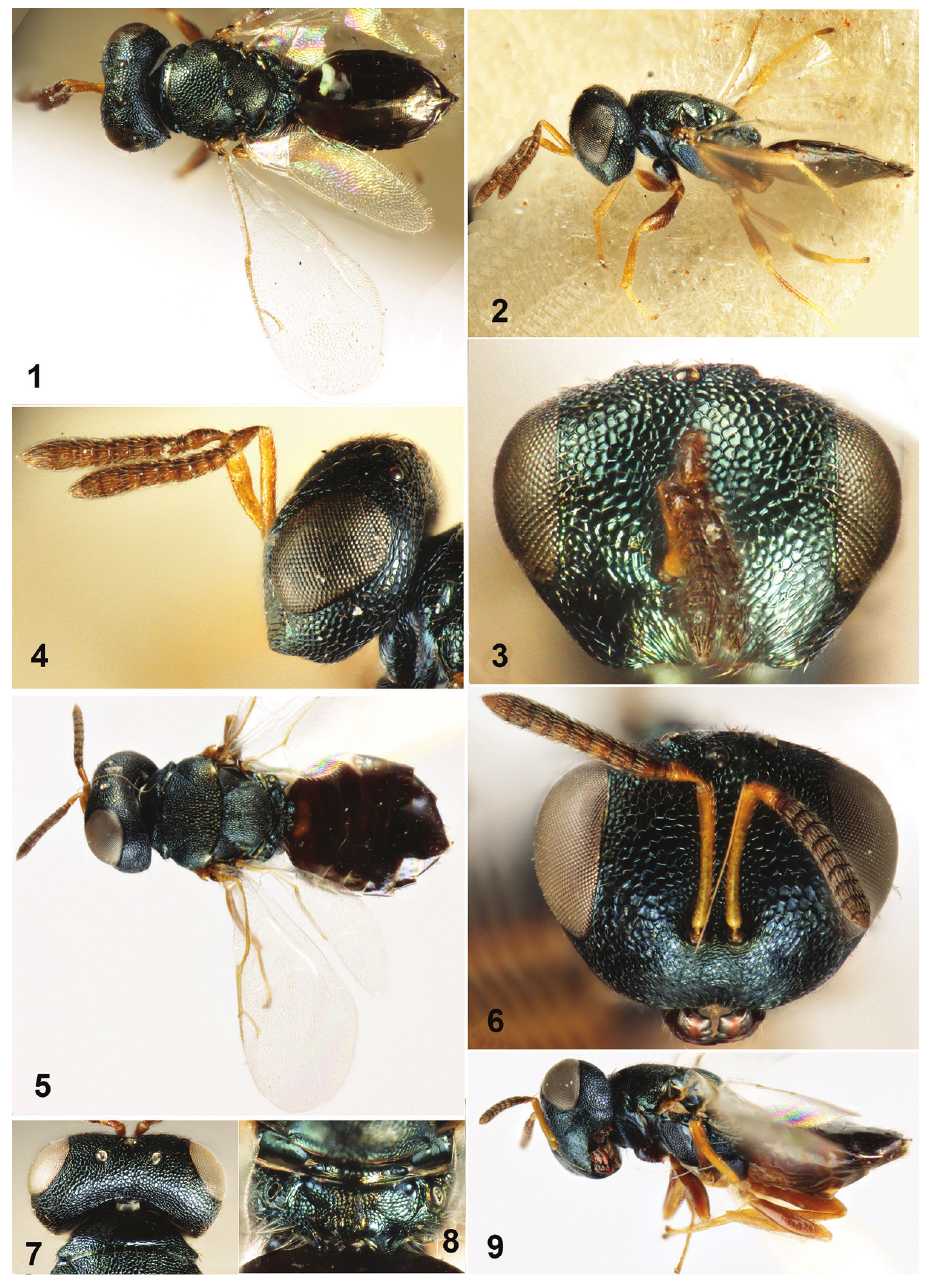
Figures 1–9. 1–4 Dibrachys hians Bouček, 1965. 1 Body in dorsal view 2 Body in lateral view 3 Head in frontal view 4 Head in lateral view 5–9 Dibrachys kojimae (Ishii, 1916) 5 Body in dorsal view 6 Head in frontal view 7 Head in dorsal view 8 Propodeum 9 Body in lateral